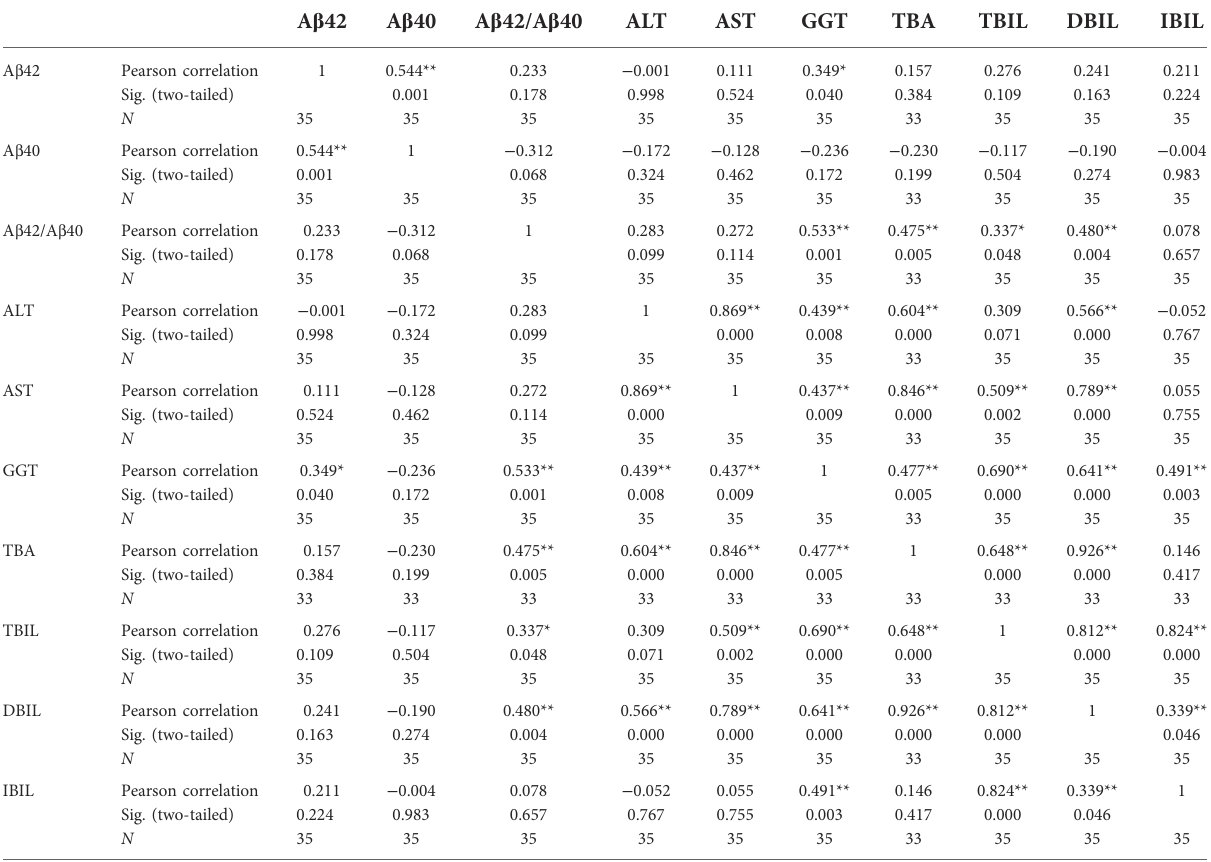
TABLE 2 Pearson correlation analysis of